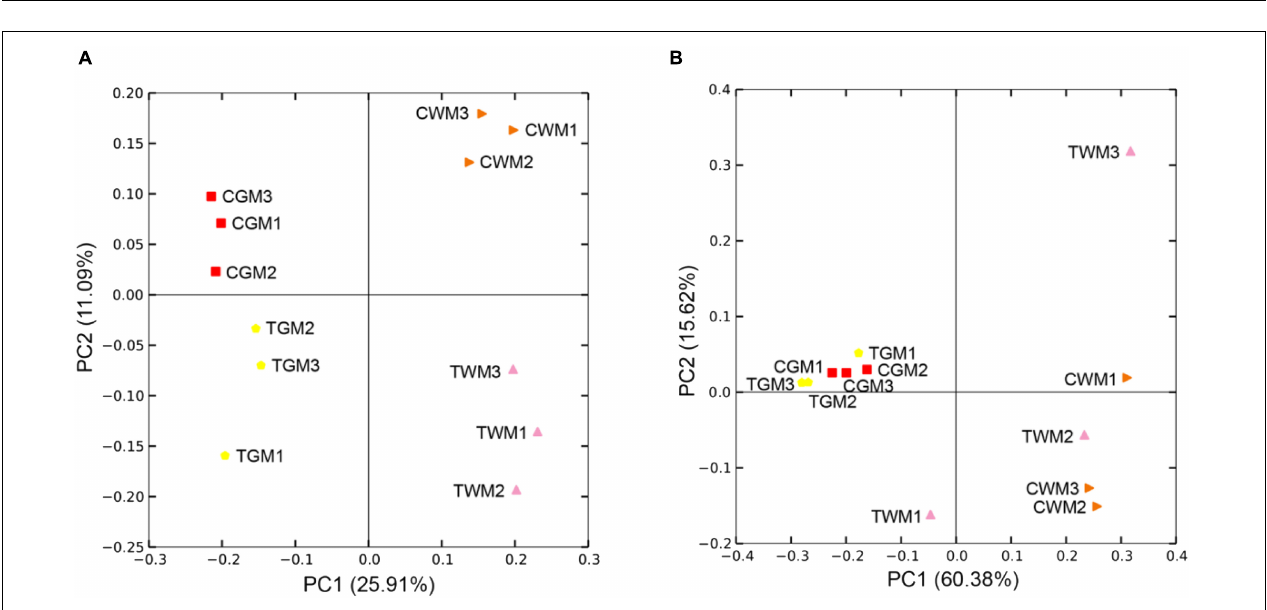
FIGURE 5 | Key phylotypes of the zebrafish gut microbiota responding to the dietary exposure to TWTP effluents, as identified using linear discriminant analysis (LDA) effect size (LEfSe): LDA scores of the differentially abundant taxa of the TWTP effluent exposure group compared with the control group (Note: the higher the LDA score, the greater the contribution to the magnitude of the variation) (A) . Cladograms based on the LEfSe analysis for the TWTP effluent groups compared with the control group (red and green circles mean differences in the relative abundance; yellow circles mean non-significant differences) (B) .